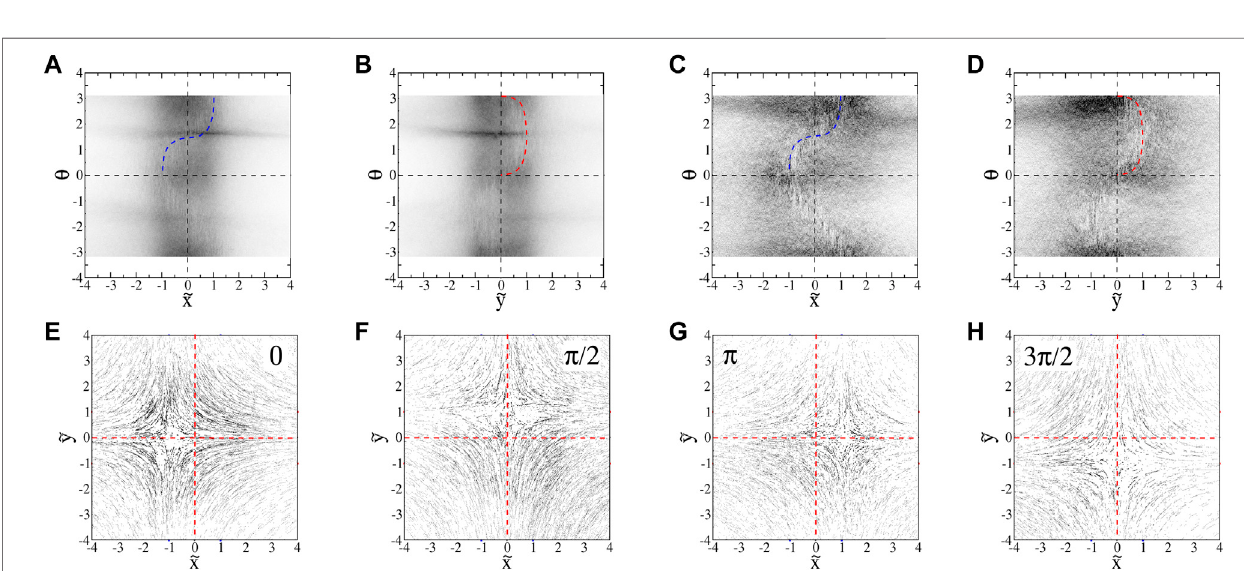
FIGURE14| :Projectionsof ( ~ x , ~ y , θ ) histogramsfortetraselmisdata.TheblueandreddashedcurvescorrespondtothetophalfofprojectionsoftheSwIMsseenin Figures 3B,C . (A,B) A = 1.8s − 1 (0.100 ml/min). (C,D) A = 3.6s − 1 (0.200 ml/min). Slices of tetraselmis histograms (0.200 ml/min fl ow, A = 3.6s − 1 ) for data within 0.1 radian of (E) 0, (F) π /2, (G) π , and (H) 3 π /2 radians. In panels (E – H) , the red dashed lines are the passive manifolds of the fl ow ’ s fi xed point.